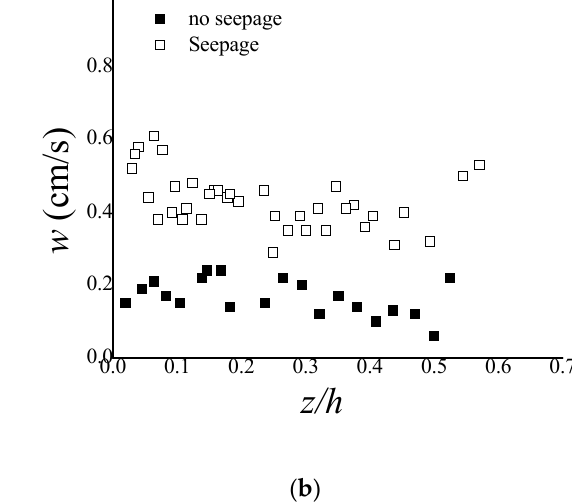
Figure 5. Vertical profiles of ( a ) time-averaged streamwise velocity ( u ) and ( b ) vertical velocity ( w ) for all experiments in this study.